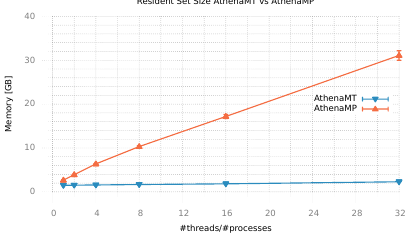
Figure 8: Memory Occupancy (Resi- dent Set Size) of AthenaMT (blue) vs. AthenaMP (orange), as a function of the number of threads or processes, respec-